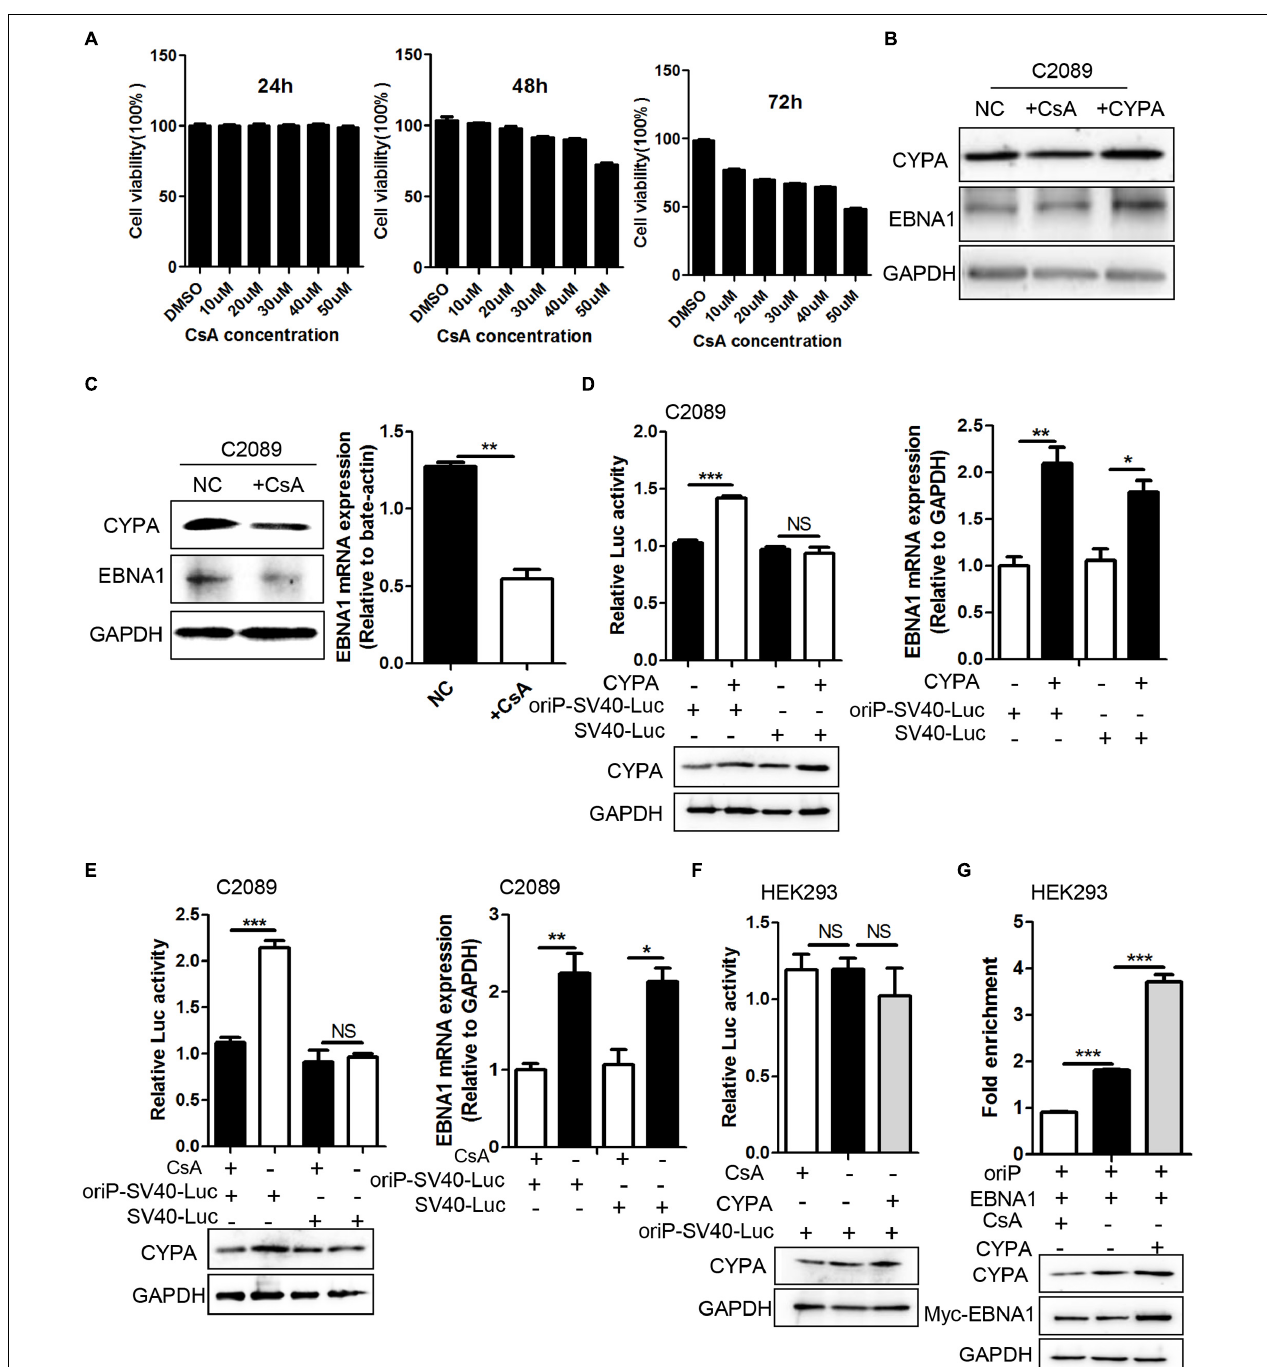
FIGURE 5 | The effect of CYPA-specific inhibitor CsA on EBNA1–mediated oriP transcription and EBNA1-oriP binding. (A) The concentration determination of CsA by Cell Counting Kit-8 (CCK-8) assay. The concentration of 40 µ M at 48 h was determined as the working concentration for treatment. (B) Rescue experiment of EBNA1 protein level after CsA treatment in C2089 cells. (C) The protein expression of CYPA and EBNA1 detected by WB assay at 48 h post-treatment with CsA. The mRNA expression of EBNA1 measured by RT-qPCR. EBV-positive C2089 cell lines were used for the test. (D) C2089 cells were transfected with oriP-SV40-Luc reporter plasmid and CYPA expression plasmids. Overexpressed CYPA significantly increased EBNA1- oriP-dependent luciferase activity, but had no effect on SV40 promoter dependent luciferase activity (left). EBNA1 mRNA was measured by RT-qPCR (right). (E) OriP-SV40-Luc reporter plasmid was transfected into C2089 cells, following the CsA treatment. CsA treatment greatly reduced EBNA1- oriP luciferase activity compared with untreatment. (F) CsA and elevated CYPA on EBNA1-oriP-mediated transcription activity in the luciferase reporter assay in HEK293 cells. (G) ChIP- qPCR was used to determine EBNA1-oriP binding. CsA treatment reduced EBNA1-oriP binding while elevated CYPA increased binding. CYPA and EBNA1 proteins were analyzed by WB. ∗ P < 0.05, ∗∗ P < 0.01, ∗∗∗ P < 0.001.